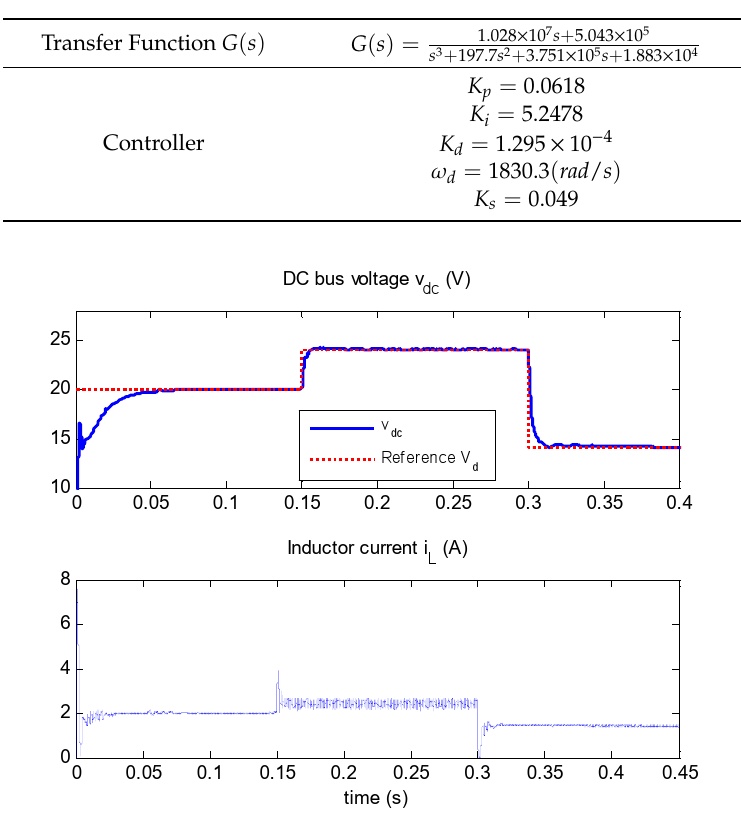
Table 3. Transfer function and controller parameters for the Fuel Cell-Buck system.